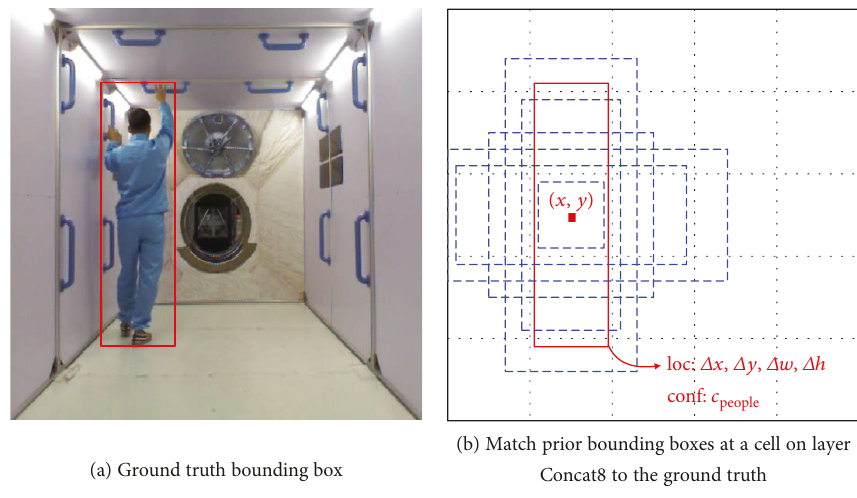
Figure 8: Match prior bounding boxes to the ground truth.